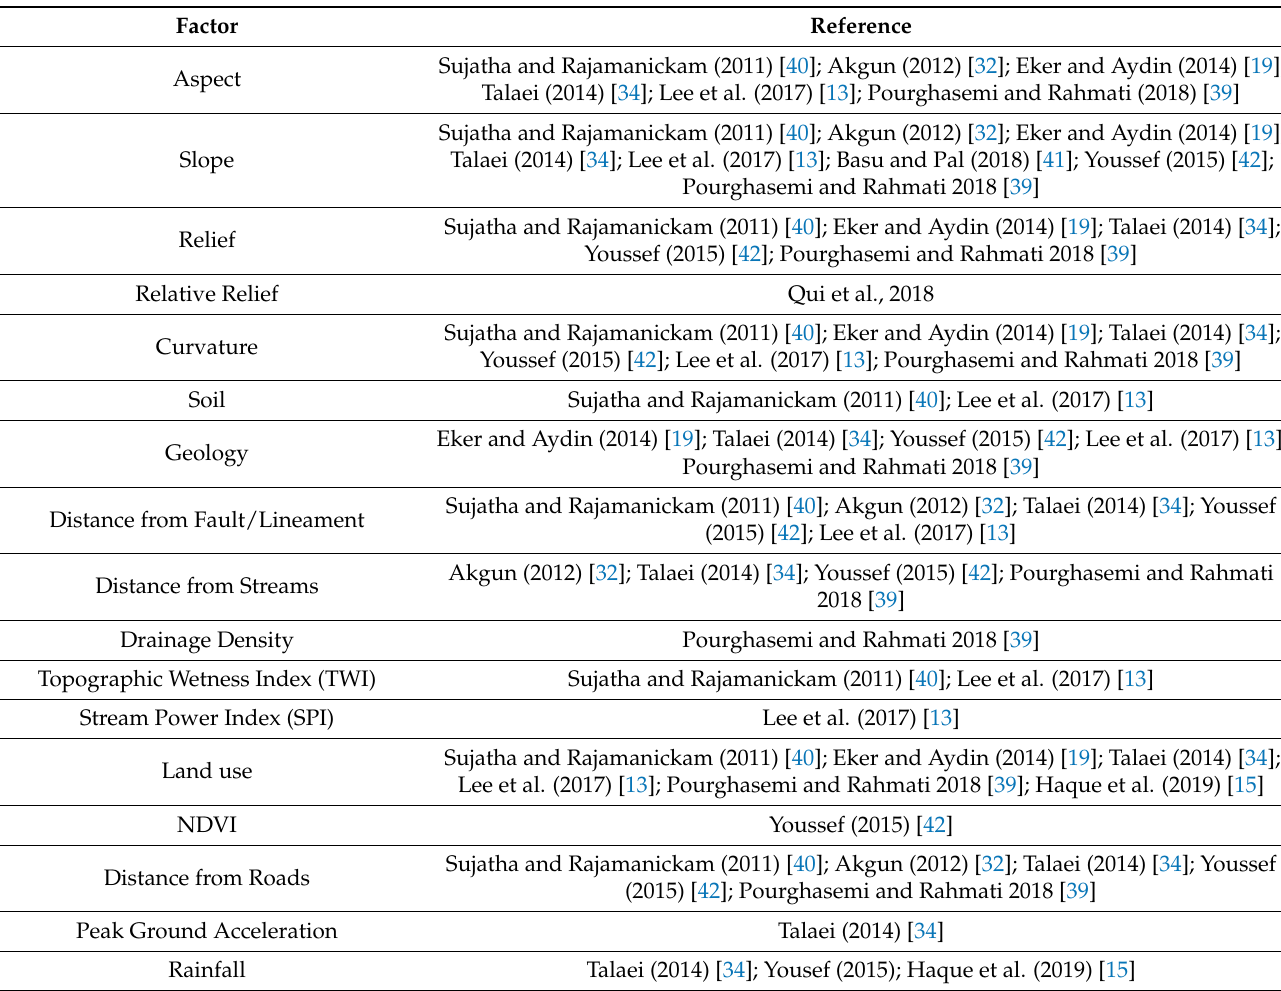
Table 1. Common Physical and Environmental Factors causing Landslides used in